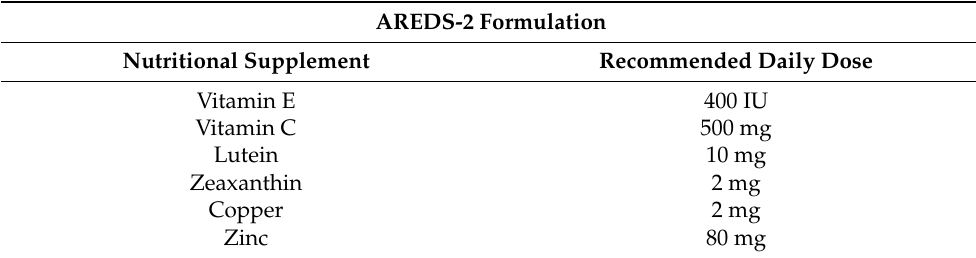
Table 1. Daily nutritional supplementation based on the results of AREDS-2